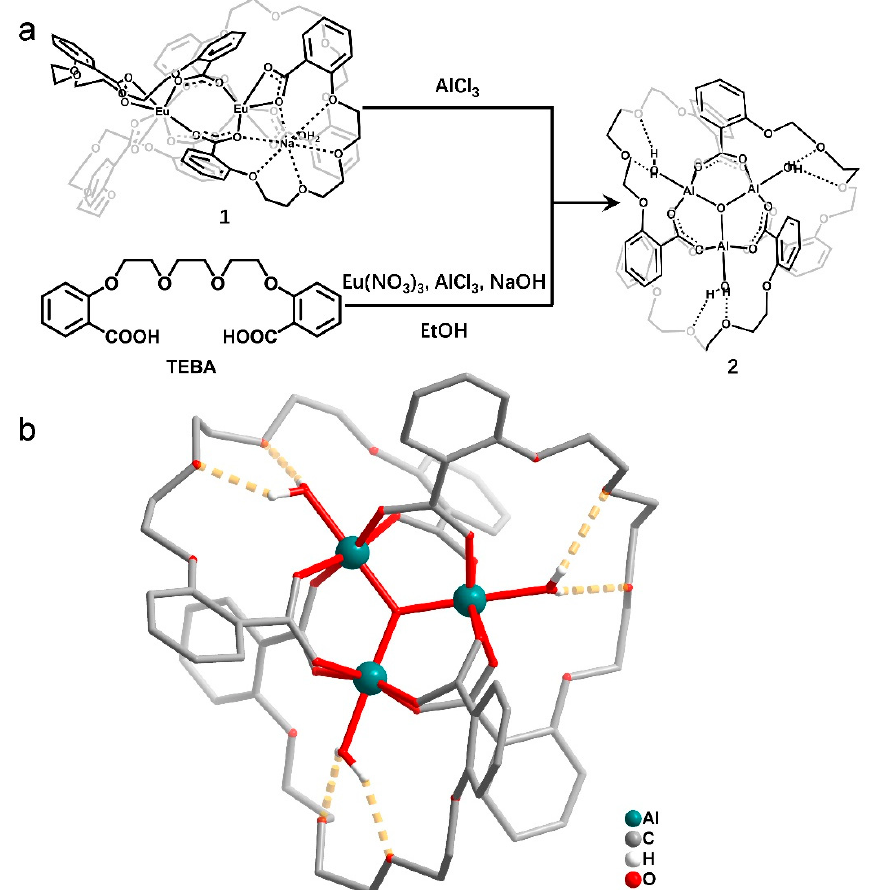
Figure 4. ( a ) The transformation and synthetic paths of compound 2 . ( b ) The molecular structure of compound 2 .